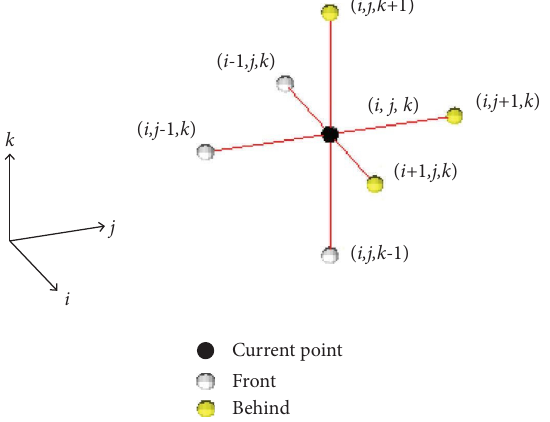
Figure 1: Schematic diagram of adjacent